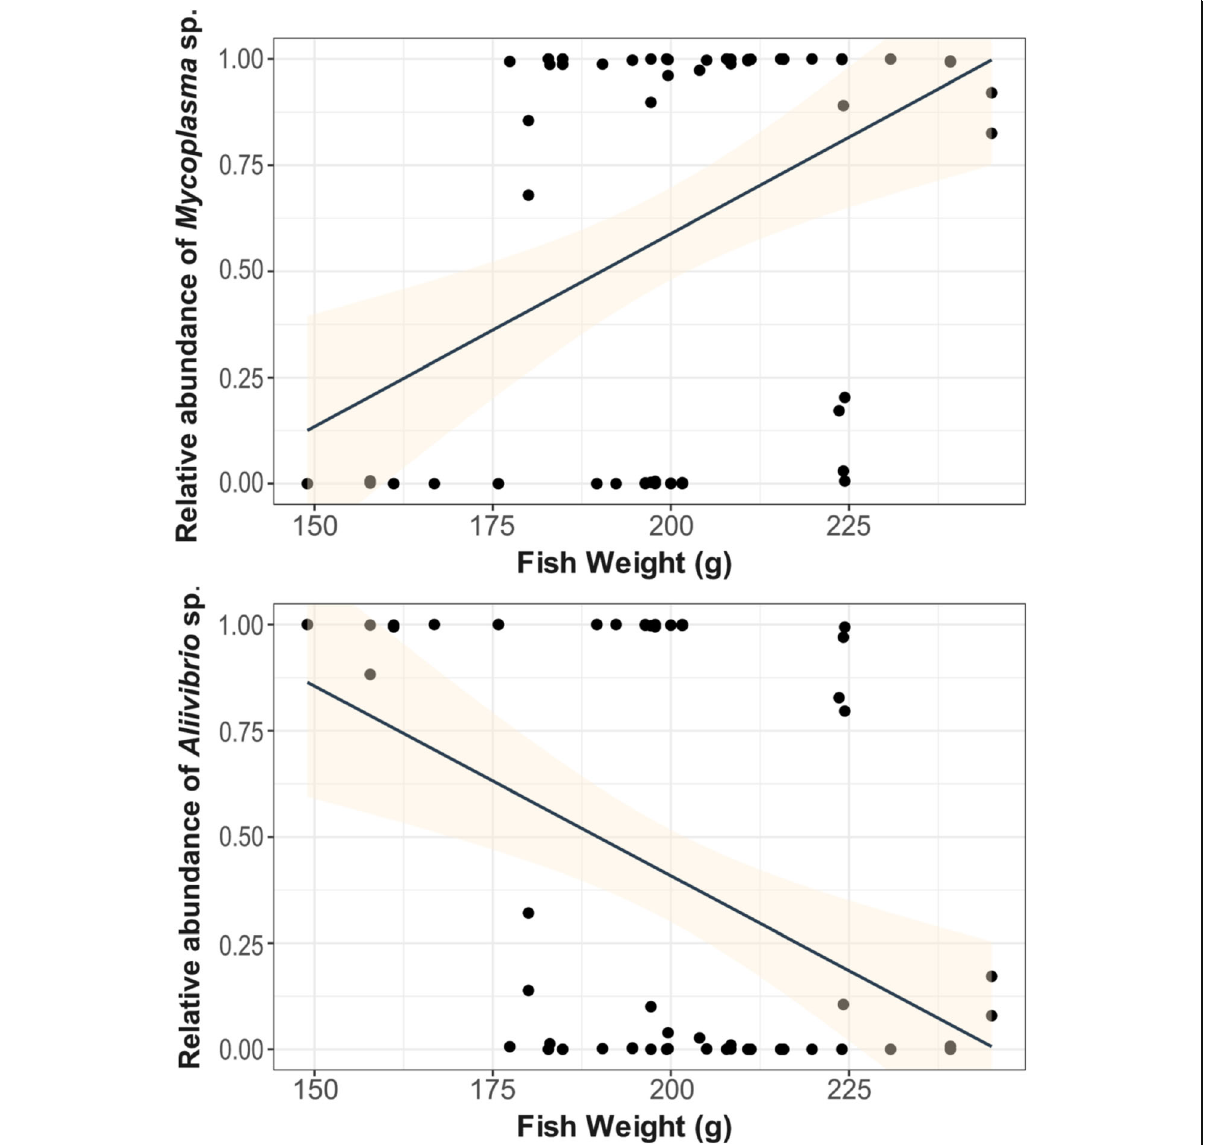
Fig. 5 Spearman ’ s rank correlation between OTUs relative abundance and fish weight. A positive correlation (Spearman ’ s R = 0.43, p < 0.001) was found when comparing Mycoplasma sp. relative abundance and fish weight (top). Similarly, a negative correlation (Spearman ’ s R = − 0.44, p < 0.001) was observed when comparing Aliivibrio sp. relative abundance with fish weight